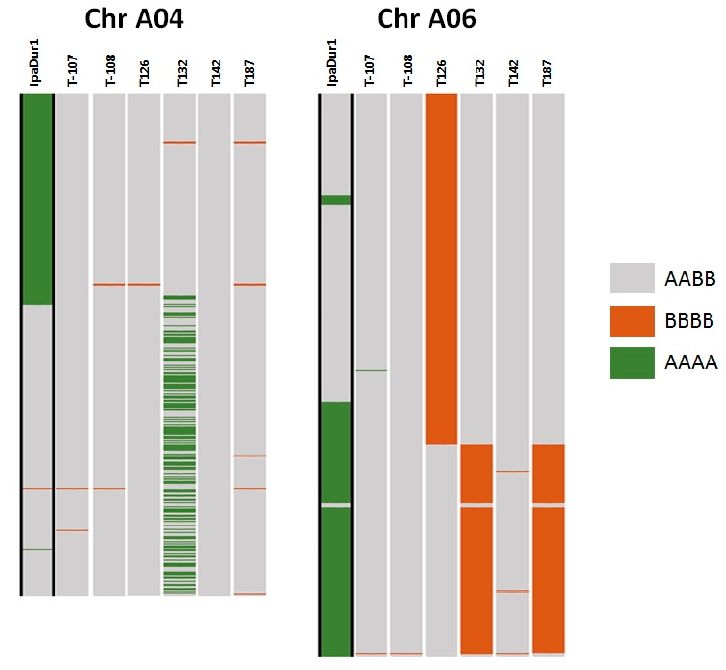
Figure 7. Representation of the tetrasomic / nullisomic allele sites on “Hot spots” for homeologous recombination: chromosomes A04 and A06, on IpaDur1, and recombinant lines T107, T108, T126, T132, T142, and T187. Gray areas are loci with expected configuration AABB, green with tetrasomic AAAA, and red, tetrasomic BBBB. Note that homeologous recombination can appear in blocks and interspersed loci. Homeologous exchange in blocks were mostly detected at the distal parts, whereas interspersed loci were detectable throughout the body of chromosomes.